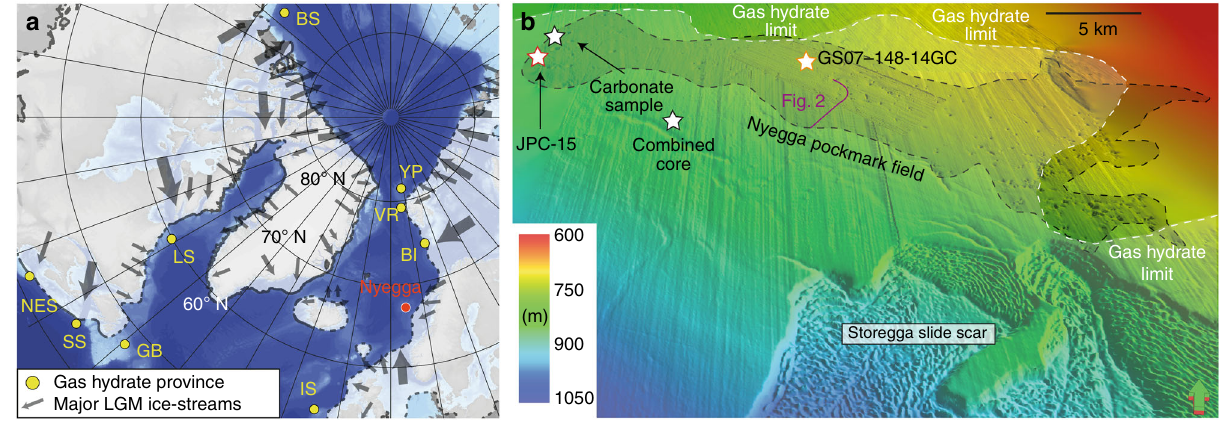
Fig. 1 Location of the Nyegga pockmark fi eld. a Map showing modelled gas hydrate occurrence around the Nordic Sea ’ s shelves, proven gas hydrate deposits (BI Bear Island trough mouth fan and Håkon Mosby mud volcano, BS Beaufort Sea, GB Grand Banks, IS Irish Sea, LS Labrador Sea, NES New England shelf, SS Scotian shelf, VR Vestnesa ridge, YP Yermak Plateau 52 , the location of the LGM Fennoscandian, Eurasian and Laurentian ice-sheets 23, 53 and the major ice-streams 54 ). The background bathymetry is from GEBCO Digital Atlas published by the British Oceanographic Data Centre on behalf of IOC and IHO (2003). b 3D view on seismic bathymetry from the Southern Vøring Plateau showing the location of the Nyegga pockmark fi eld, the extent of gas hydrates 8 (white dashed line) and the Storegga slide scar. Locations of sediments cores, carbonate sample and the combined cores are marked with stars. The bathymetry is from 3D seismic data provided by the Norwegian Petroleum Directorate and extracted using the seismic interpretation